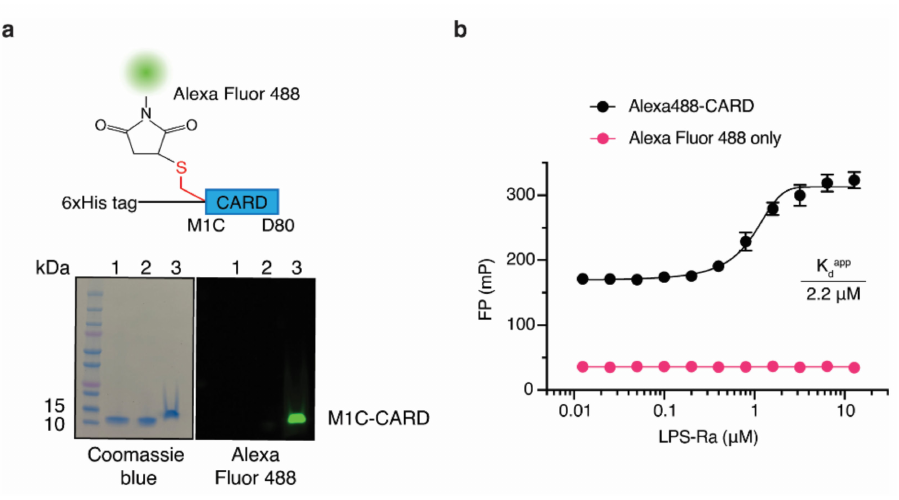
Figure 2. An FP-based assay using Alexa488-CARD and LPS-Ra. ( a ) Schematic structure of Alexa488- CARD and Coomassie blue staining (left) and fluorescence (right) images of an SDS-PAGE gel of M1C-CARD purified by Ni-NTA column chromatography (lane 1) and Superdex200 column chromatography (lane 2) and after labeling with Alexa Fluor 488 (lane 3). ( b ) FP binding curves of 50 nM Alexa488-CARD or dye only incubated with varying concentrations of LPS-Ra. Standard deviations presented in the graph were calculated from three independent